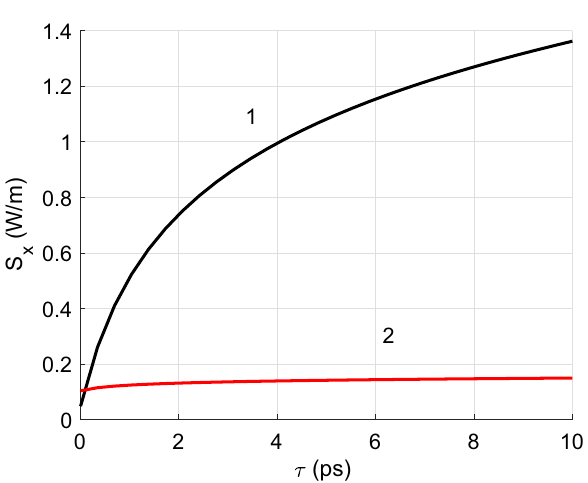
6 and magenta lines for m 1 12 . = =